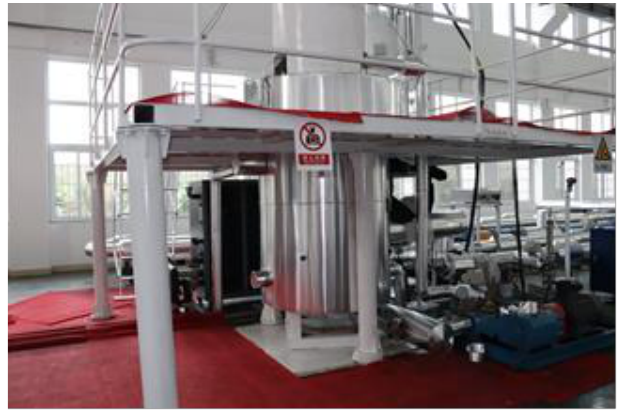
Figure 2. The preparation kettle of non-diagenetic natural gas hydrate in three-in-one method.